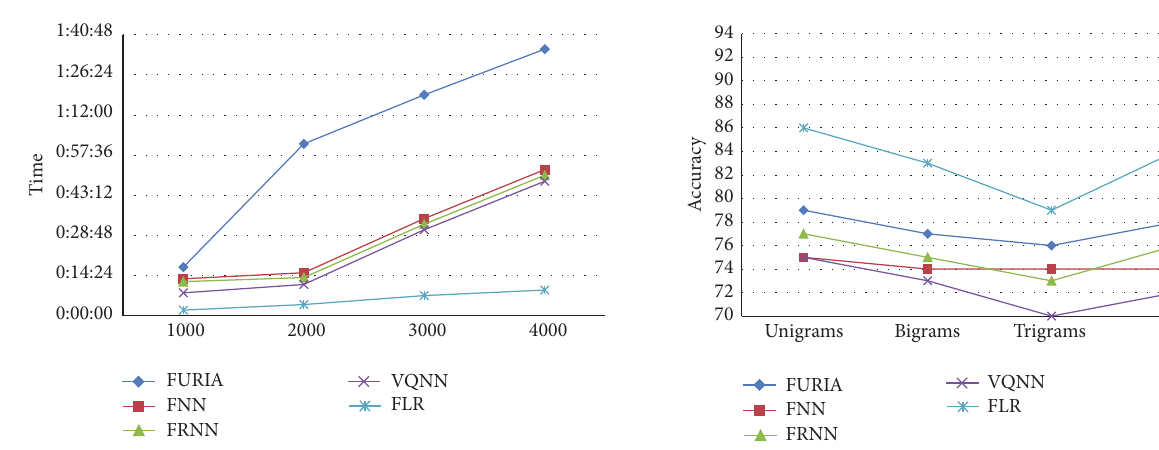
Figure 3: Classifier prediction time with different instances sizes on hotels dataset.